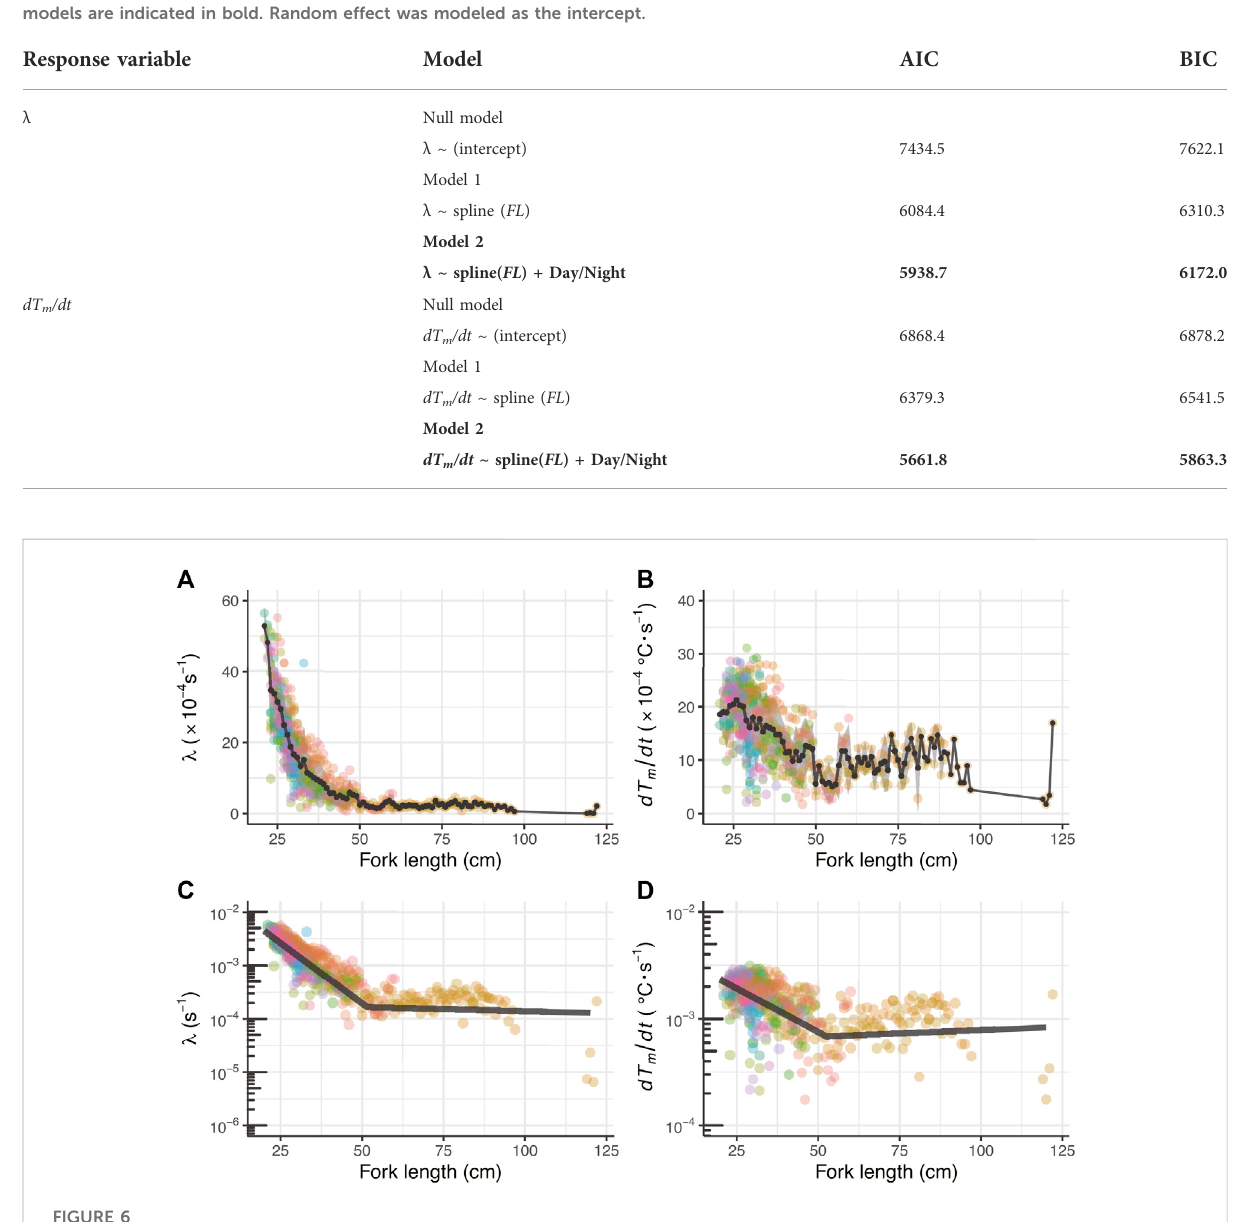
FIGURE 6 Changing relationship of λ and dT m /dt throughout their ontogeny (A) Relationship between fork length and λ (B) Relationship between fork length dT m /dt . The colored circles represent parameters estimated by the heat-budget model for each individual. The black circles connected by lines and the shaded area represent mean values and s.d. Per by fork length, respectively (C) Segment regression analysis for λ and (D) dT m /dt . The dark gray lines refer to the segment regression predicted lines for the log-transformed